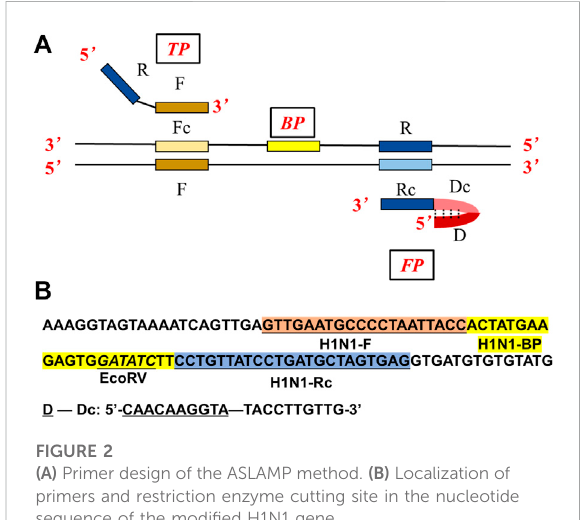
FIGURE 2 (A) Primer design of the ASLAMP method. (B) Localization of primers and restriction enzyme cutting site in the nucleotide sequence of the modi fi ed H1N1 gene.